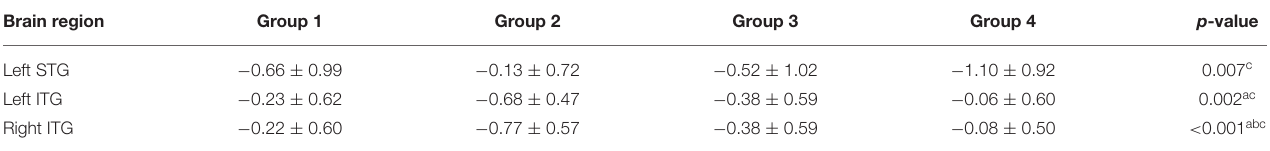
TABLE 3 | The fALFF values of brain regions where HL and cognition interact. Brain region Group 1 Group 2 Group 3 Group 4 p -value Left STG − 0.66 ± 0.99 − 0.13 ± 0.72 − 0.52 ± 1.02 − 1.10 ± 0.92 0.007 c Left ITG − 0.23 ± 0.62 − 0.68 ± 0.47 − 0.38 ± 0.59 − 0.06 ± 0.60 0.002 ac Right ITG − 0.22 ± 0.60 − 0.77 ± 0.57 − 0.38 ± 0.59 − 0.08 ± 0.50 < 0.001 abc